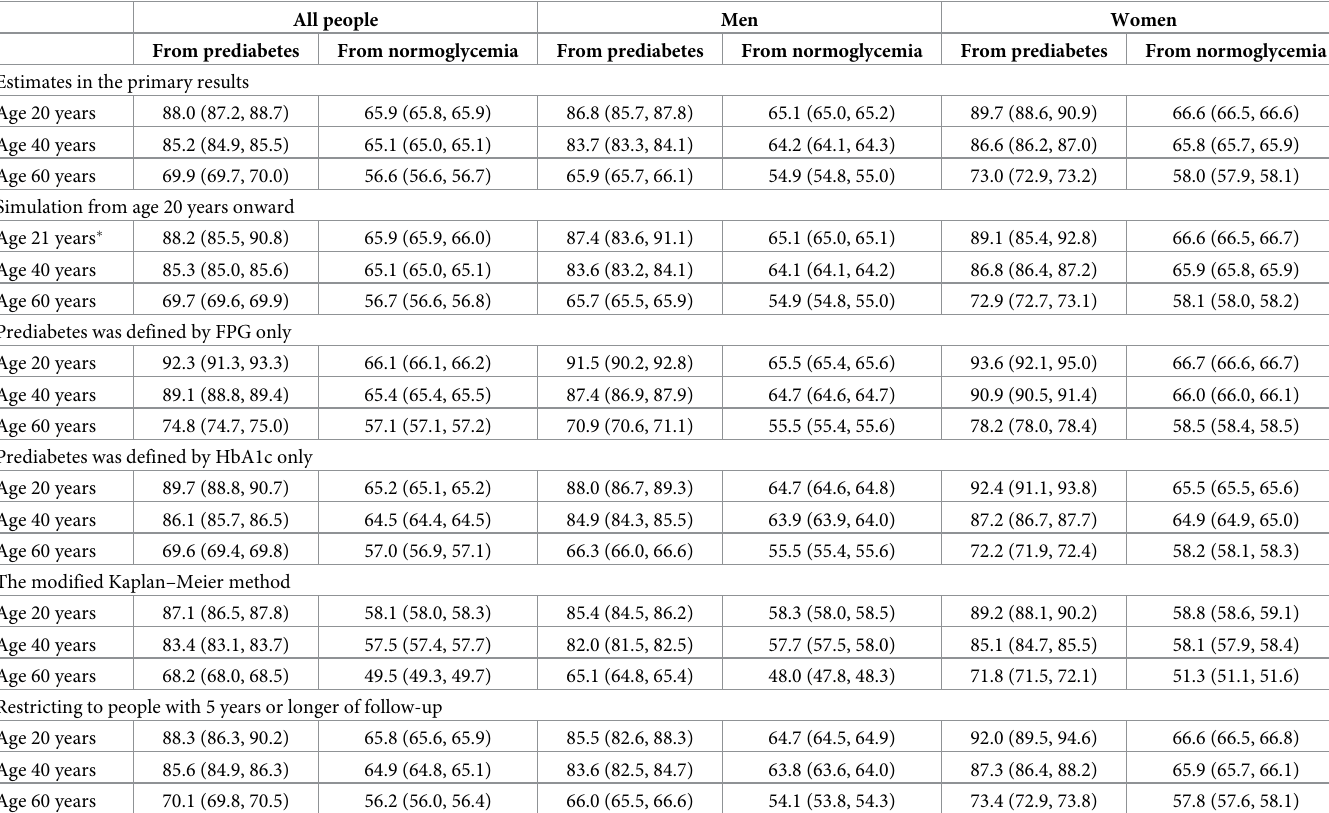
Table 2. Expected remaining lifetime risks of progression from prediabetes and normoglycemia to diabetes, expressed as percentages, at age 20, 40, and 60 years estimated in primary analyses and sensitivity analyses. All people Men Women From prediabetes From